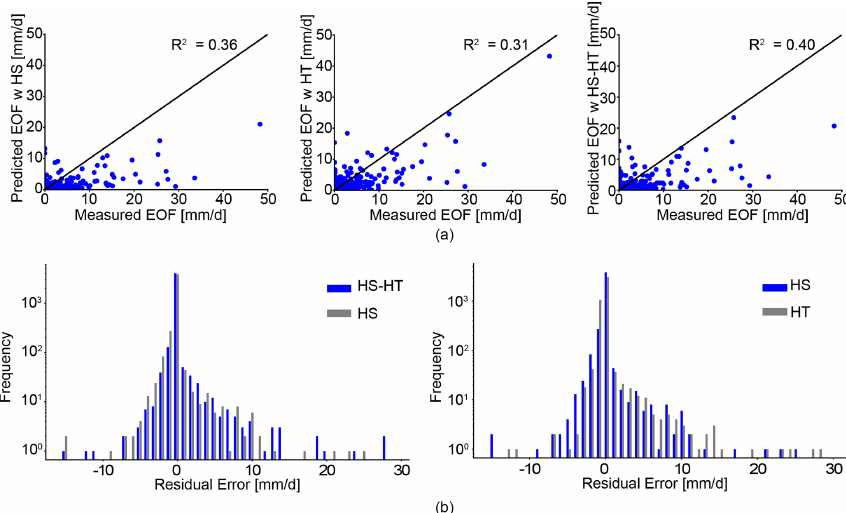
Figure 6. (a) Comparison of the observations with the predictions of daily EOF runoff for the Maumee domain by the XGBoost models trained using the HS, HT, and HS–HT approaches, respectively. (b) Comparison of residual errors between the observations and the predic- tions of daily EOF runoff for the Maumee domain by the XGBoost models trained using the HS–HT, HS, and HT approaches, respectively.